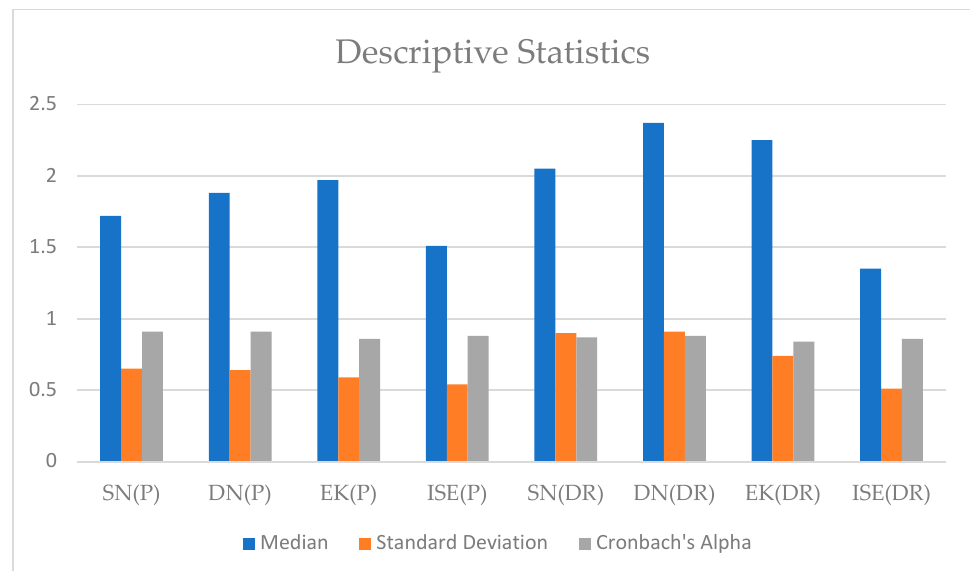
Figure 4. Graphical presentation of findings.